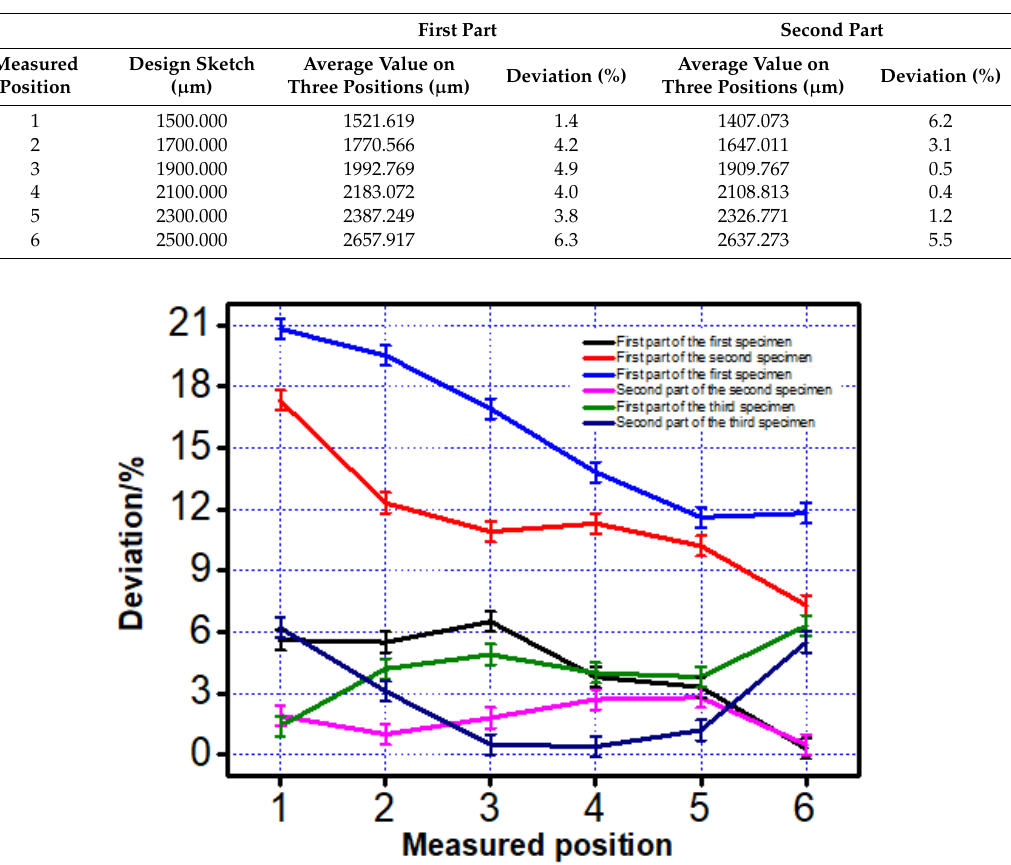
Figure 10. Deviation of the three specimens on both the first and second part.